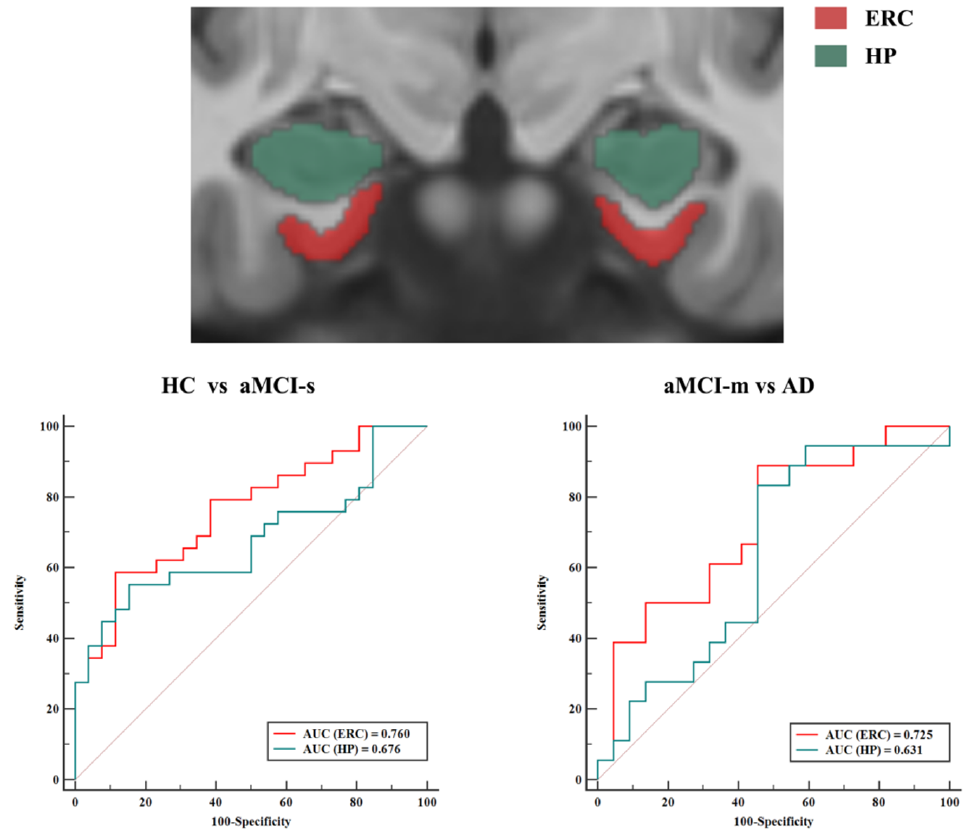
Figure 2. The ERC vs. HP in discriminating HC from aMCI-s and aMCI-m from AD. Red: entorhinal cortex; green: